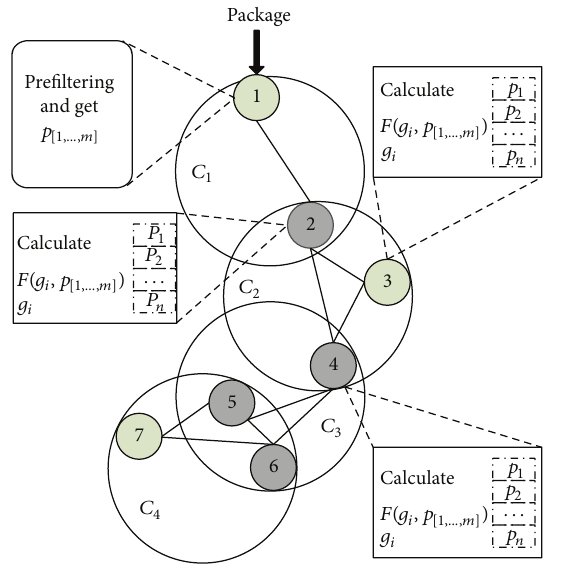
Figure 3: Matching process of ad hoc packages.